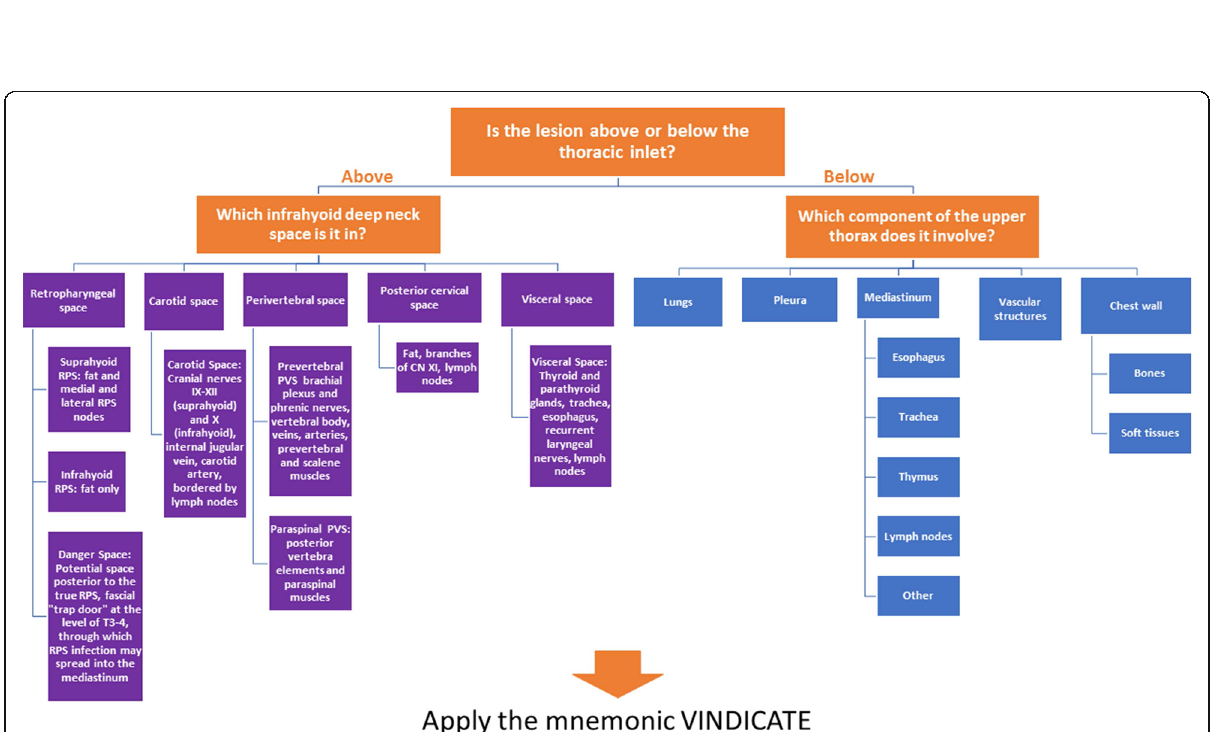
Fig. 4 Algorithmic approach to pathology of the thoracic inlet region